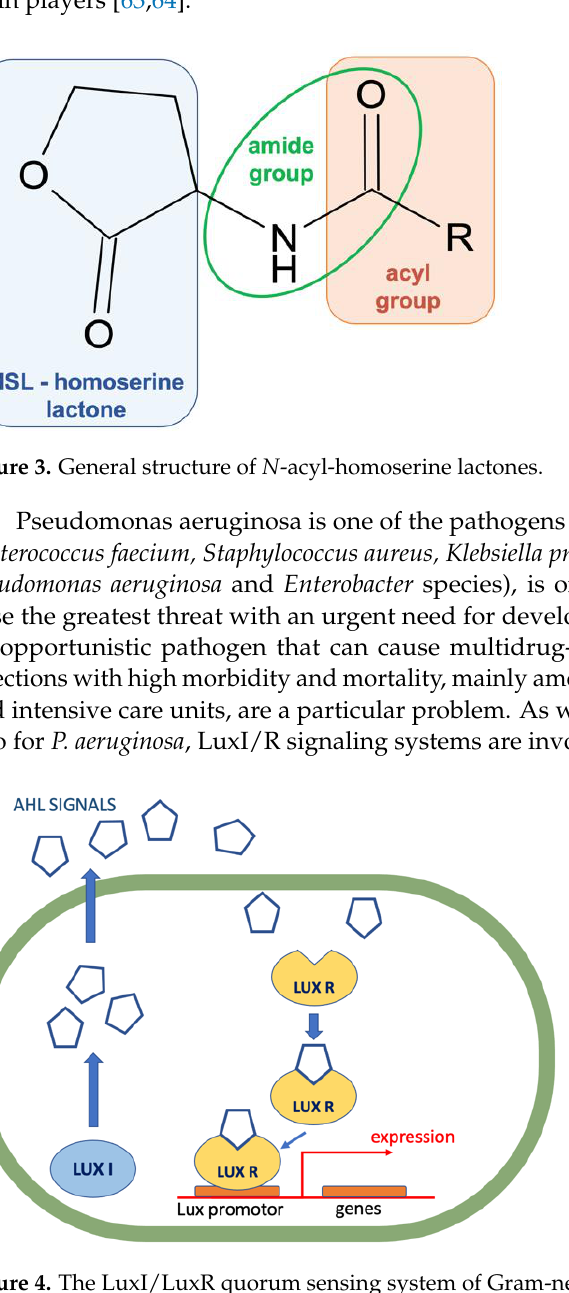
Figure 4. The LuxI/LuxR quorum sensing system of Gram-negative bacteria.